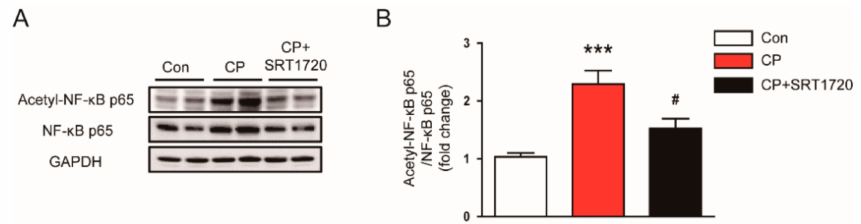
Figure 9. E ff ects of SRT1720 on acetylation of nuclear factor kappa-B (NF- κ B) p65 in kidneys of mice treated with cisplatin. ( A ) Western blots of acetyl-NF- κ B p65 and NF- κ B p65 levels in kidneys. ( B ) Quantification of acetyl-NF- κ B p65 level. *** p < 0.001 vs. Con. # p < 0.05 vs.